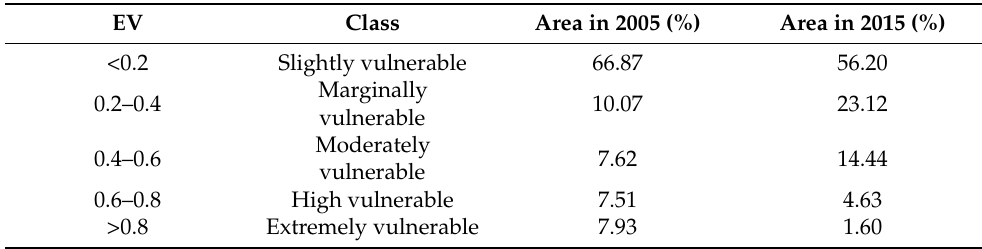
Figure 4. The overall ecological vulnerability assessment results of Chongming Island in 2010 ( a ) and 2015 ( b ). Table 2. The statistics of the ecological vulnerability assessment results of Chongming Island in 2005 and 2015.